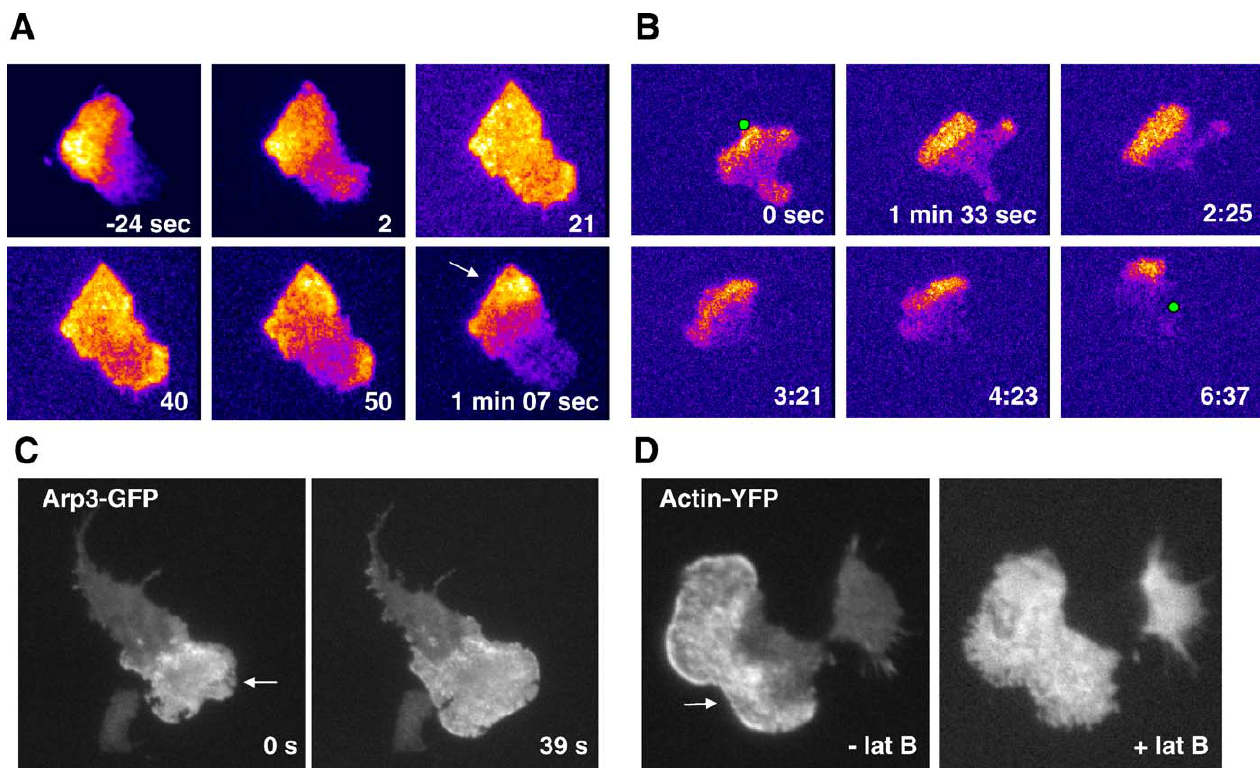
Figure 2. Rac Activity and the Arp2/3 Complex Spatially Correlate with but Are more Homogeneous than Hem-1 Waves (A) Pak-GBD-YFP (Rac activity probe) dynamics during acute cell stimulation (chemoattractant added to pre-polarized cell at t ¼ 0 s)—see Video S8. Rac activation is initially uniform and then polarizes (arrow), similar to the spatial dynamics of Hem-1 waves (compare to Figure 4B). Rac exhibits relatively homogeneous zones of activation in contrast to discrete points and waves of Hem-1. (B) Rac activity dynamics during cell migration (see Video S9). Rac-GTP (assayed by Pak-GBD-YFP) concentrates at the leading edge (and dominant pseudopod when multiple pseudopodia are present) in cells migrating in uniform chemoattractant. Green dots are included in first and last frame as fiduciary marks to clarify relative cell positions. (C) The Arp3-GFP component of the Arp2/3 complex fills the leading edge (arrow) and exhibits a more homogeneous distribution than Hem-1 waves (Video S10). The cell is representative of more than five similar cells. (D) Actin-YFP is more homogeneously distributed than Hem-1 waves throughout the leading edge of polarized cells. Latrunculin treatment of actin- YFP–expressing cell abolishes leading edge accumulation of actin-YFP. Cells are representative of more than five similar